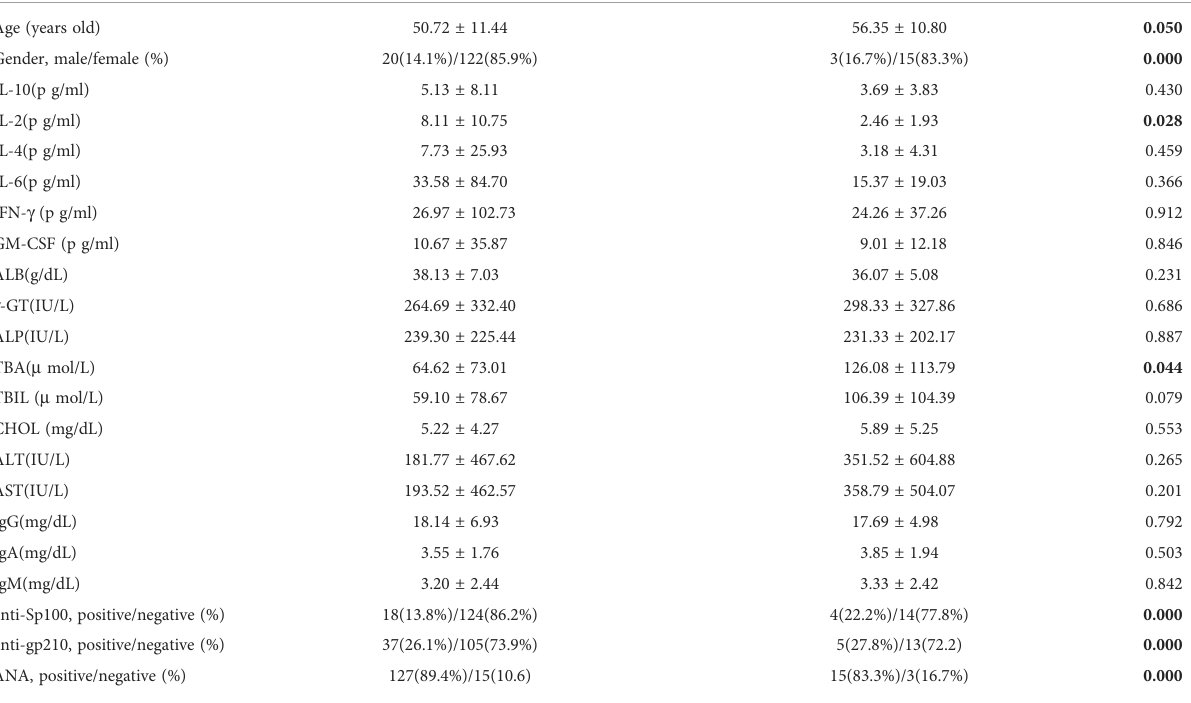
TABLE 2 Comparison of baseline clinical and laboratory parameters levels at entry between patients with and without liver failure. Parameters